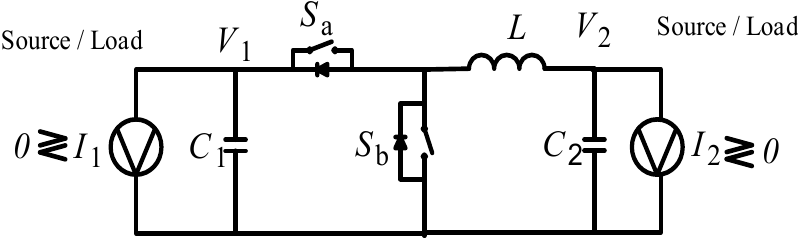
Figure 5. Main circuit topology: non-isolated bi-directional DC–DC converter based DCSOP.